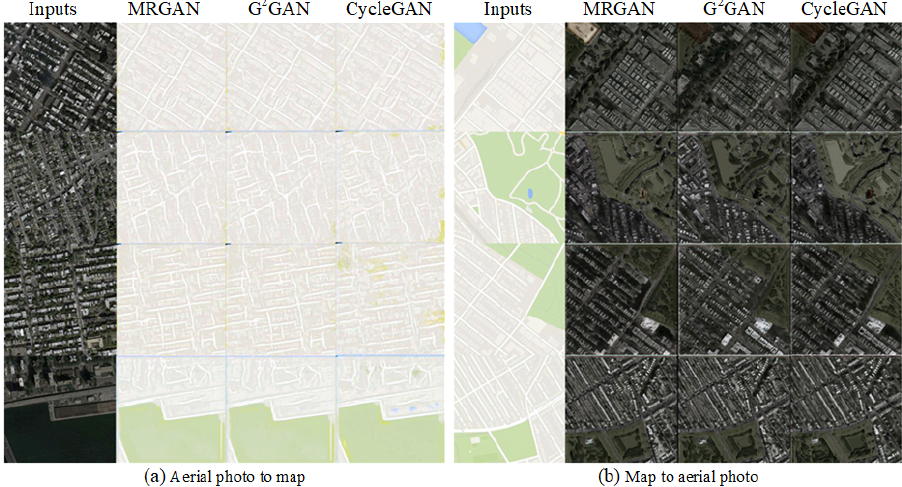
Figure 6. The results on map transformation task. ( a , b ) show the result images respectively using MRGAN, G 2 GAN and CycleGAN for map transformation between aerial photos and 2D